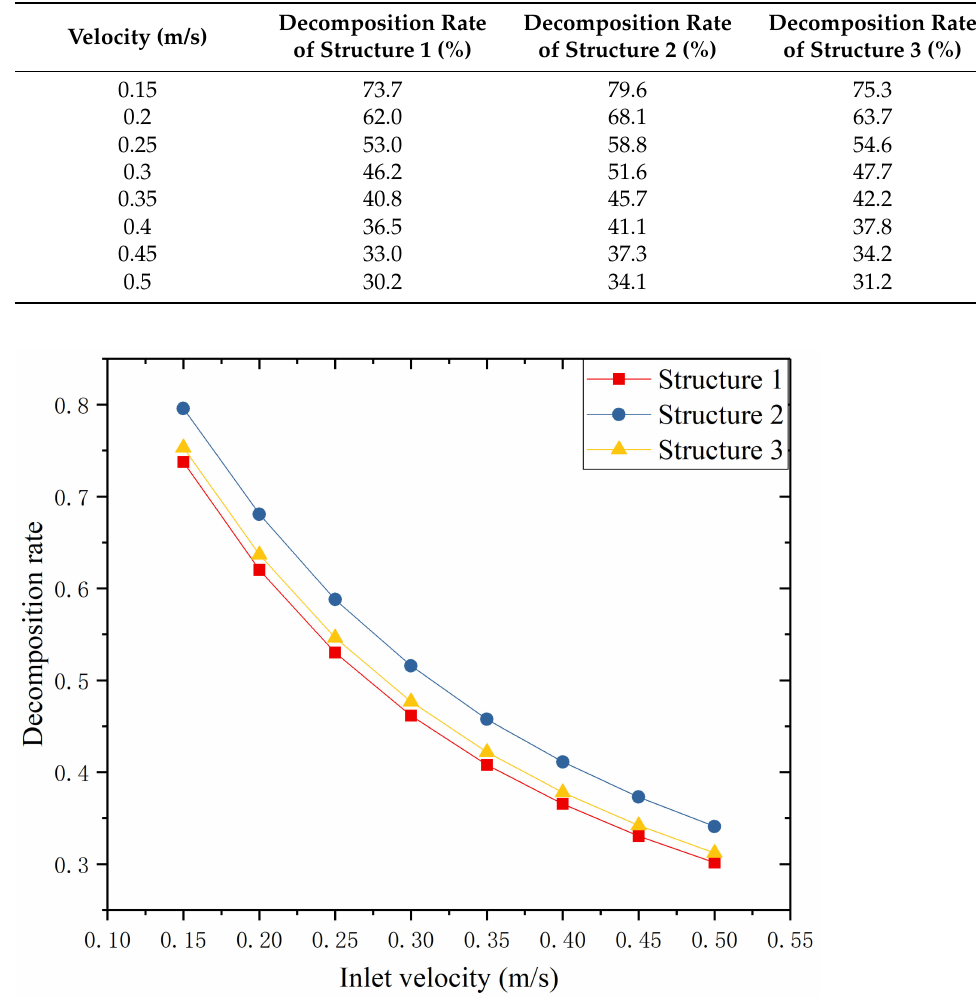
Figure 12. Decomposition rates for various velocities of